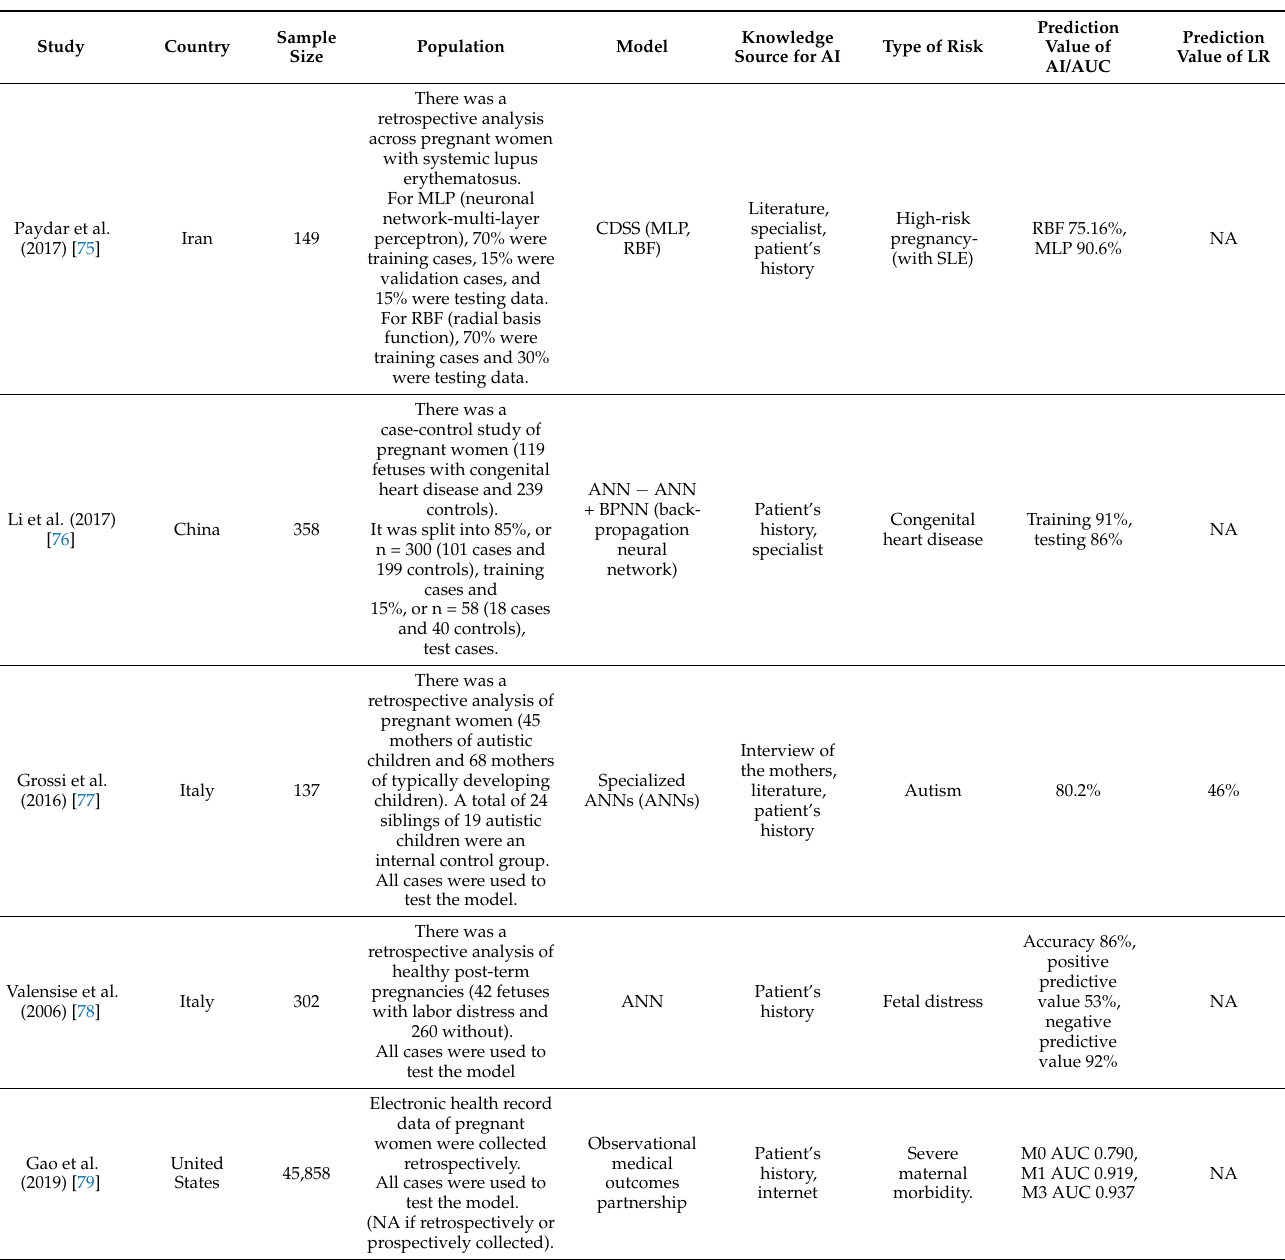
Table 10. Characteristics of other included